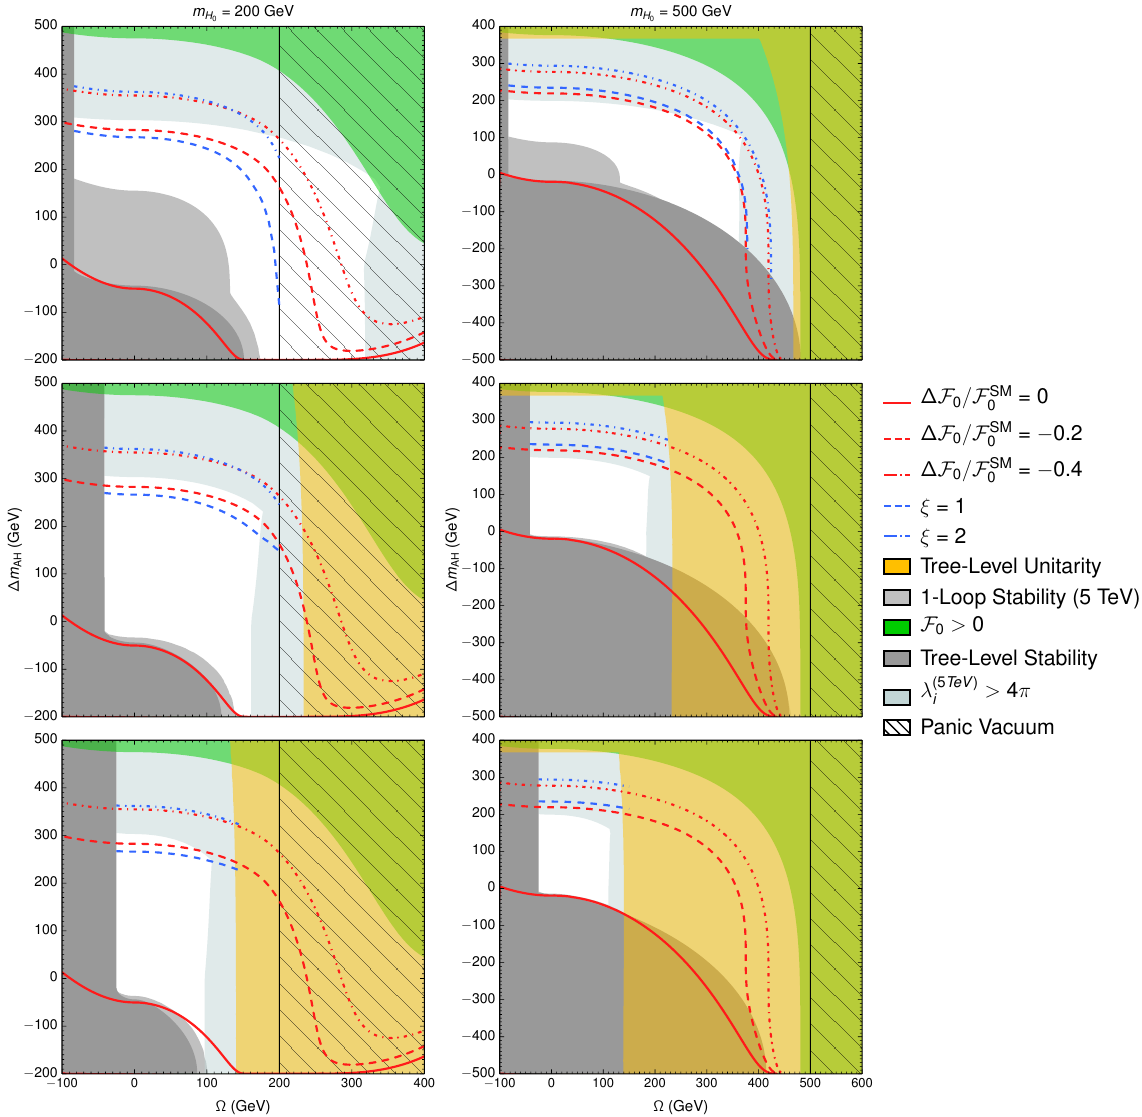
Figure 7 . (cid:10) vs (cid:1) m AH assuming m t (cid:12) = 1 : 5 ; 3 ; 5 (Top to Bottom). Labels as in (cid:12)gure 6.